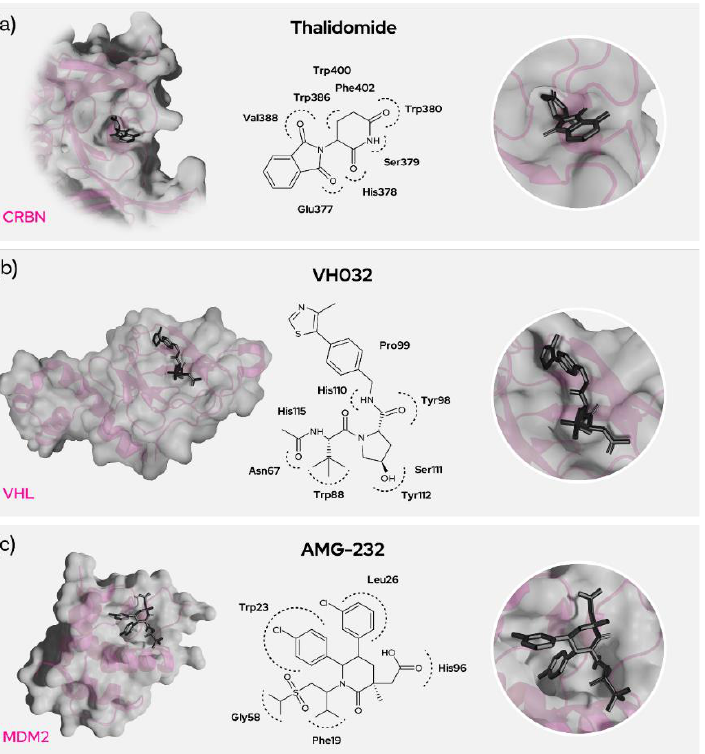
Figure 5. Prominent recruiters and binding residues. ( a ) Interacting residues between CRBN and Thalidomide, ( b ) VH032 and VHL as well as ( c ) AMG-232 and MDM2.